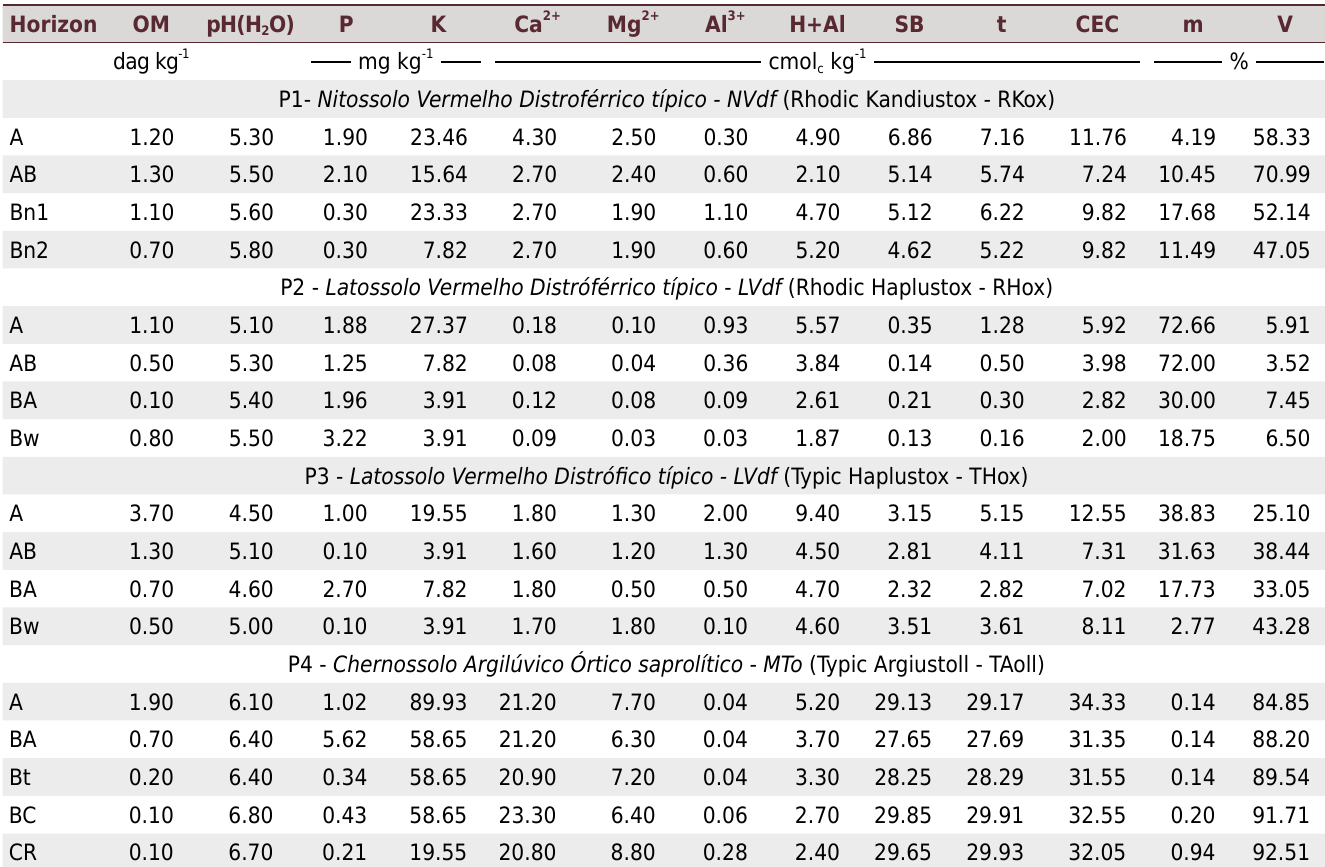
Table 2. Chemical properties of soils of the Southern Espinhaço Mountain Chain and Upper Jequitinhonha Valley Horizon